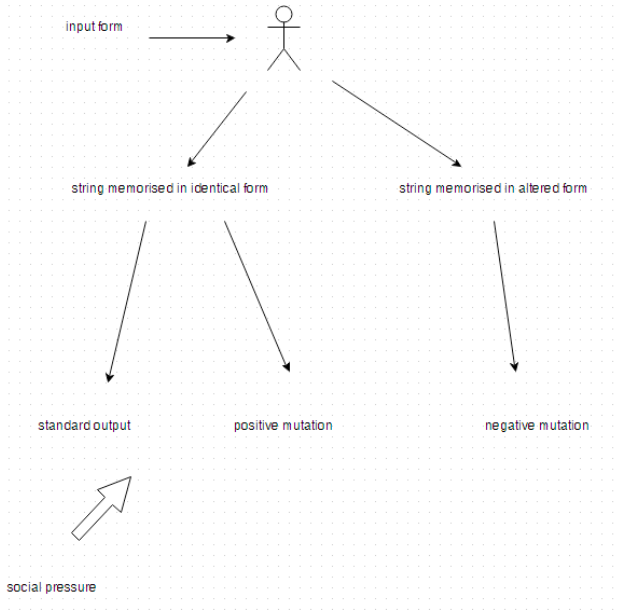
Figure 1: Lexical selection process for any given